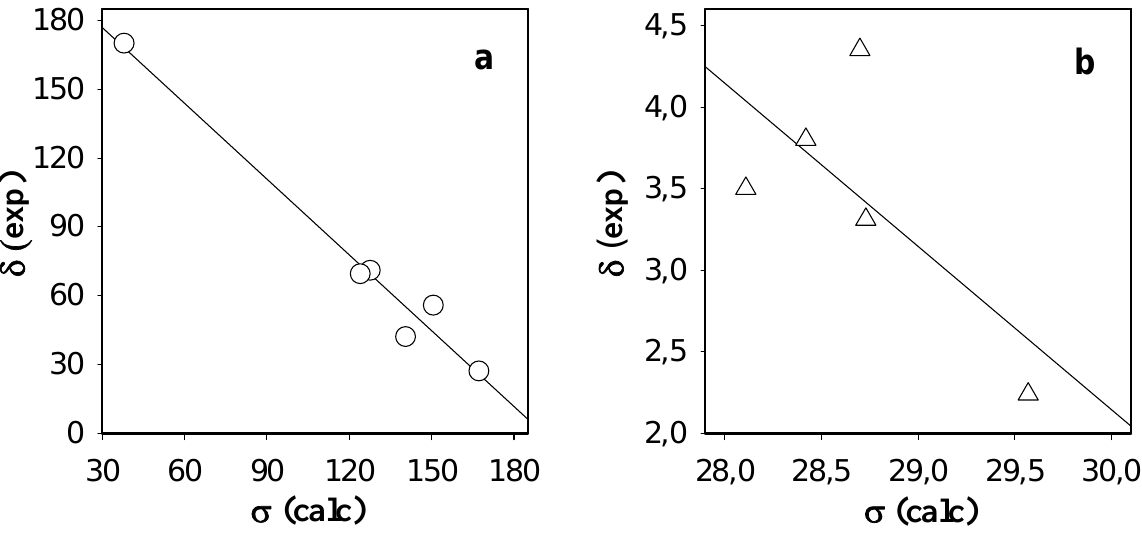
, D O) in 1,1-dimethyl-1-carboxymethyl-3- exp 2